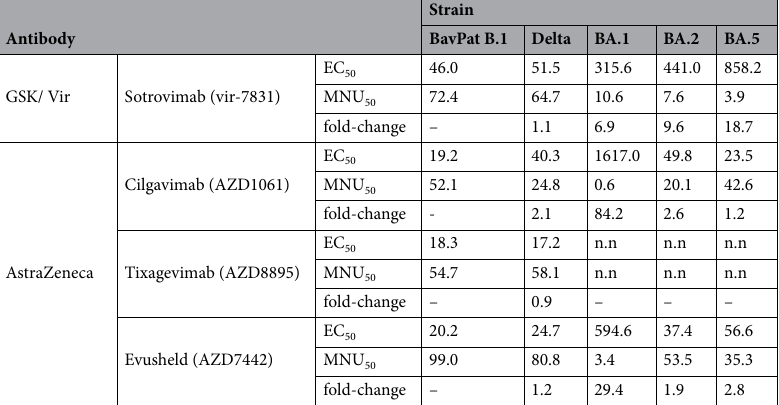
Table 1. Activity of therapeutic antibodies against B.1, Delta and Omicron BA.1, BA.2 and BA.5 variants. Interpolated EC 50 values are expressed in ng/mL. For B.1, BA.1 and BA.2 strains, the EC 50 is the mean of two independent experiment (n = 2), each including three replicates. (n.n: non-neutralising). MNU 50 : neutralizing capacity per treatment expressed in million units. One unit is defined as the amount of a given antibody needed to provide 50% neutralization of 100 TCID50 of a given strain. Doses refer to treatments authorized in the European Union (Sotrovimab: 500 mg IV 21 ; AZD7442: 300 mg IM (Cilgavimab 150 mg + Tixagevimab 150 mg). Fold change reduction were calculated in comparison with the ancestral B.1